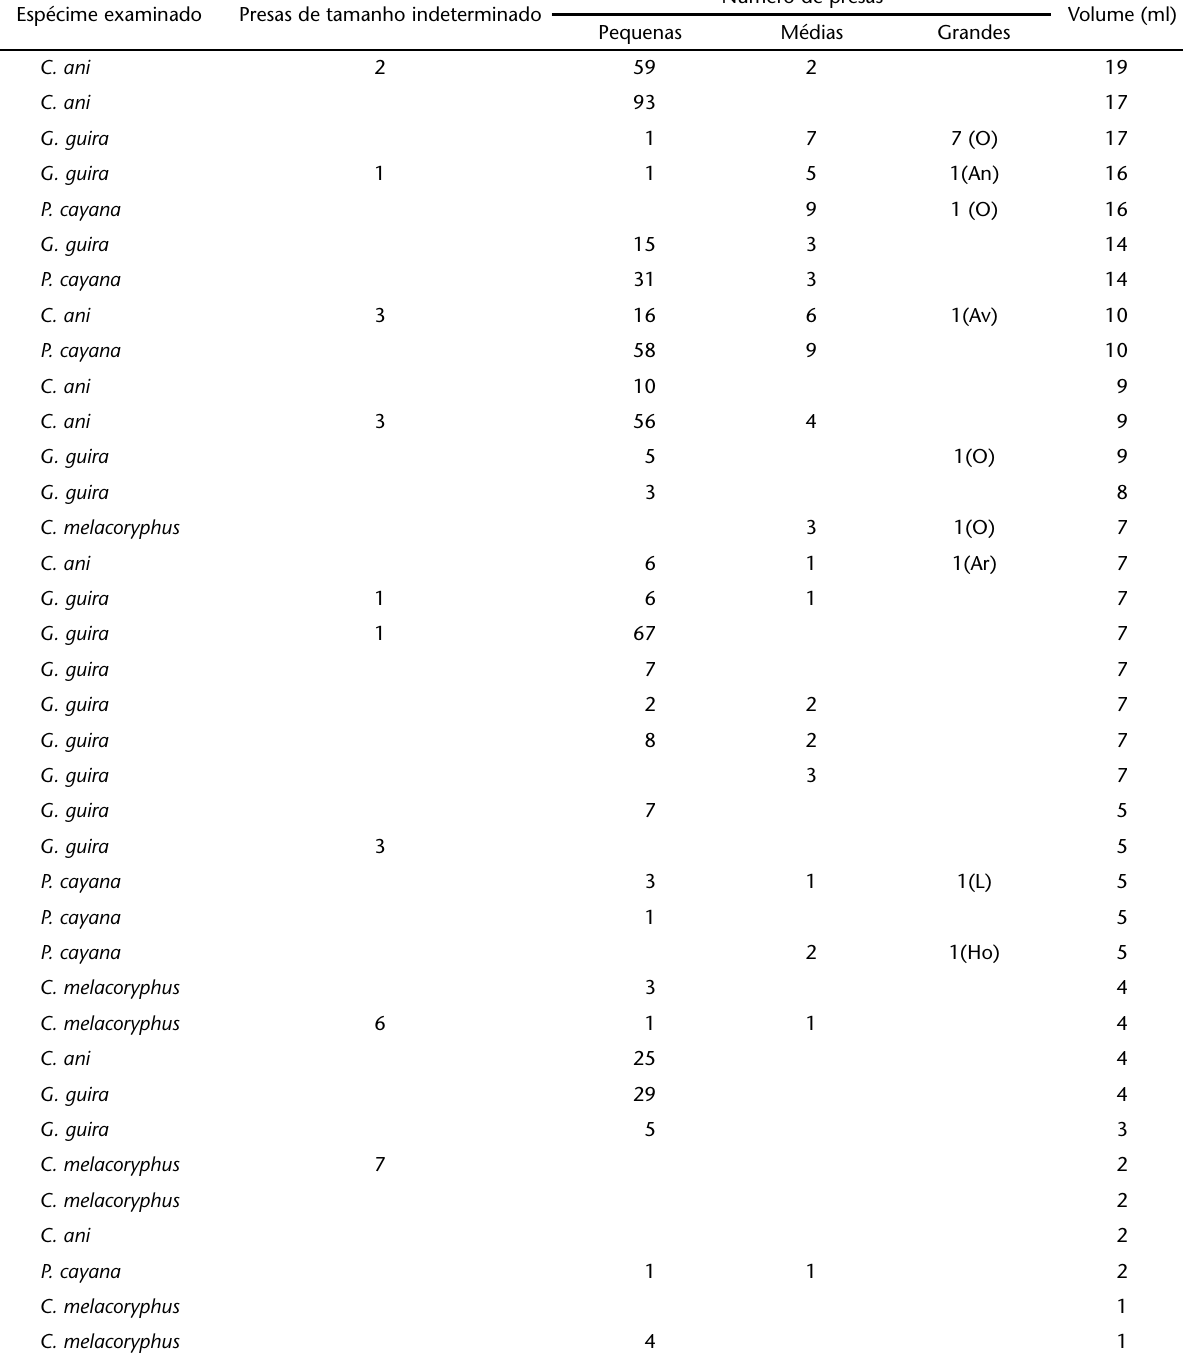
Tabela II. Número de presas/estômago examinado de quatro espécies de Cuculidae, a partir de espécimes depositados na Coleção Ornitológica da PUCRS. Ordenação decrescente pelo volume do estômago. Grupos taxomômico correspondentes à presas grandes indicados entre parênteses. (O) Orthoptera, (L) Lepidoptera, (Ho) Homoptera, (Ar) Araneae, (An) Anura, (Av) Ave. Espécime